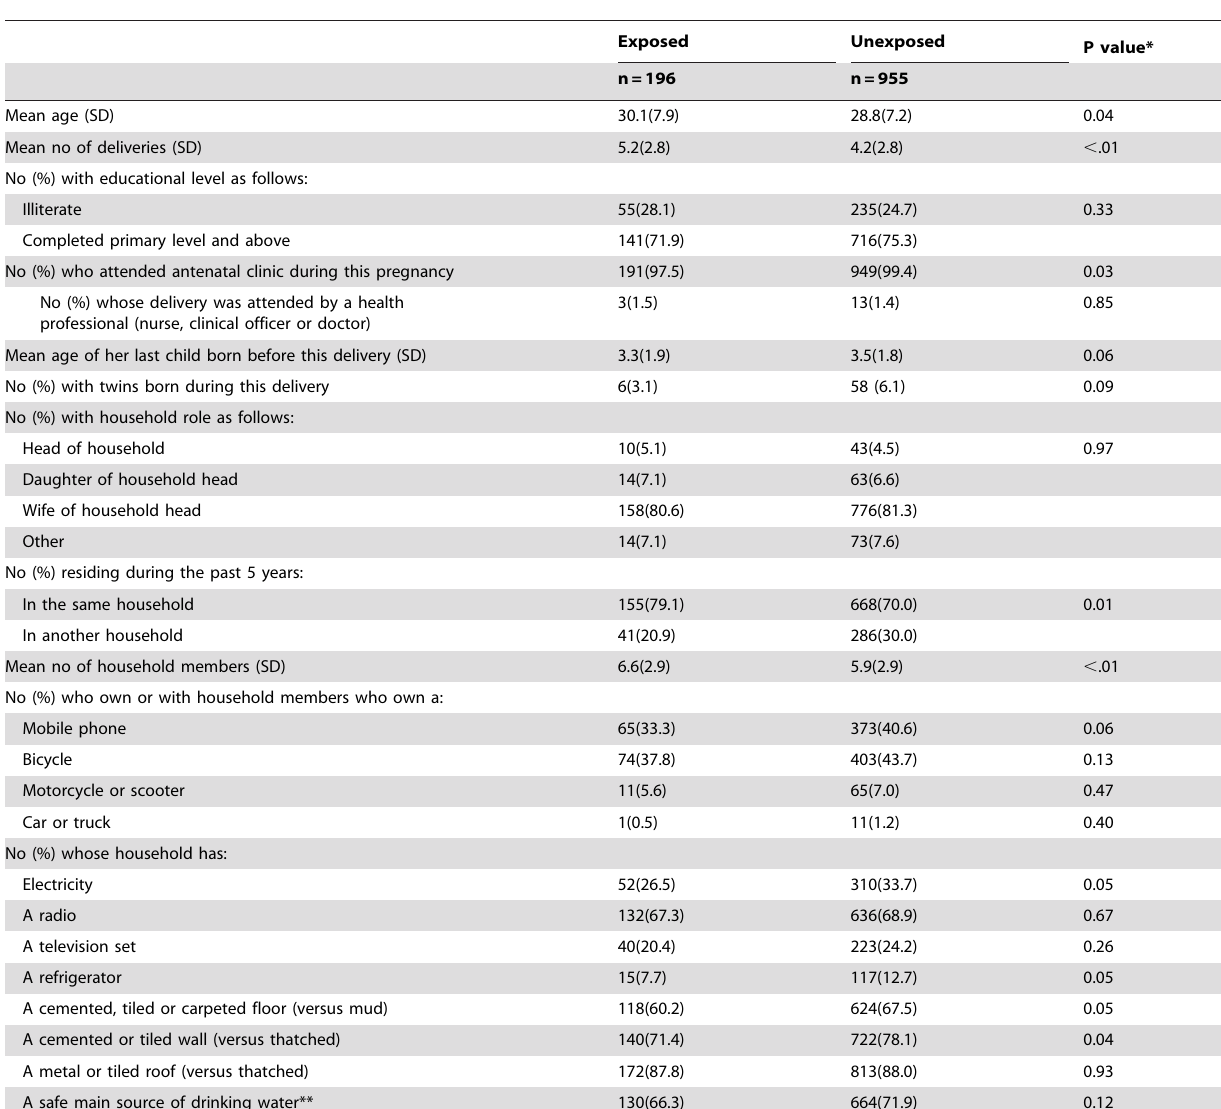
Table 2. Comparison of individual and household characteristics between mothers exposed and unexposed to the oral cholera